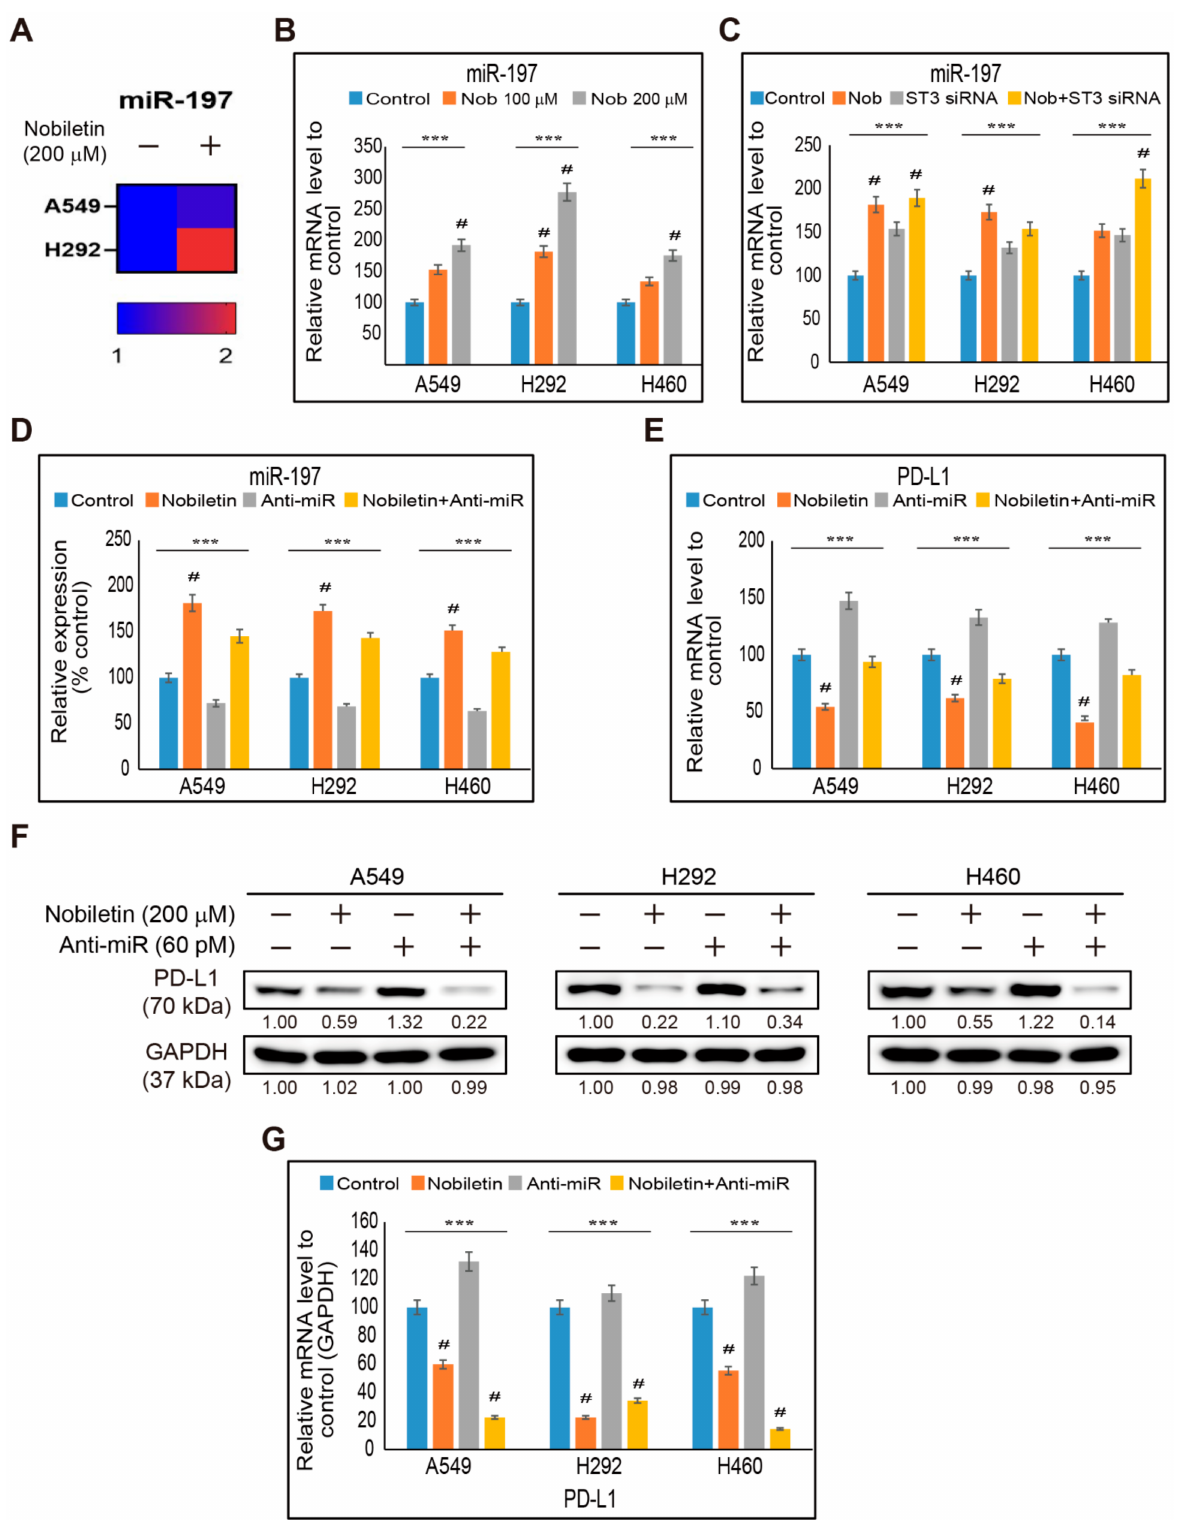
Figure 6. Nobiletin upregulates miR-197 and regulates PD-L1 expression. ( A ) Heat map displaying the fold changes related to the mean expression of miR-197 in non-treated and nobiletin-treated A549 and H292 cells. ( B ) Real-time qPCR of miR-197 expression upon treatment with 100 and 200 µ M nobiletin for 48 h in A549, H292, and H460 cells. The representative expression of miR-197 mRNA is shown; Cp values were then normalized to U6 mRNA. Controls are set to 100. *** p <